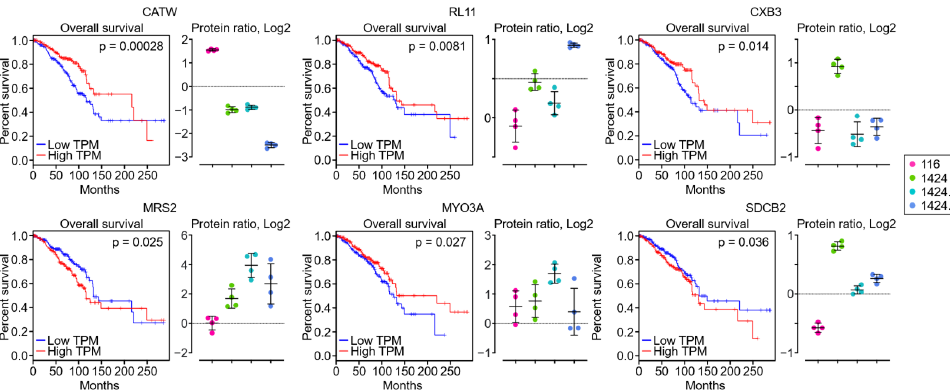
Figure 5. Survival plots and corresponding protein exosome abundances of six metastatic-specific altered proteins with p < 0.05 in the survival analysis.